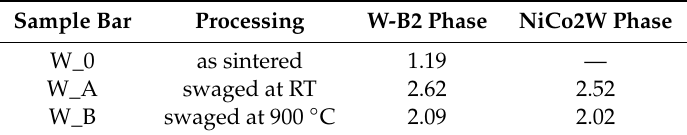
Table 1. Relative maximum intensities in the pole